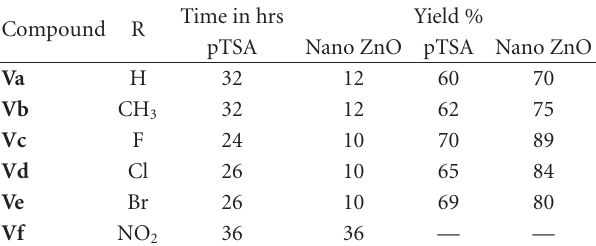
Table 3: Comparison of pTSA and ZnO